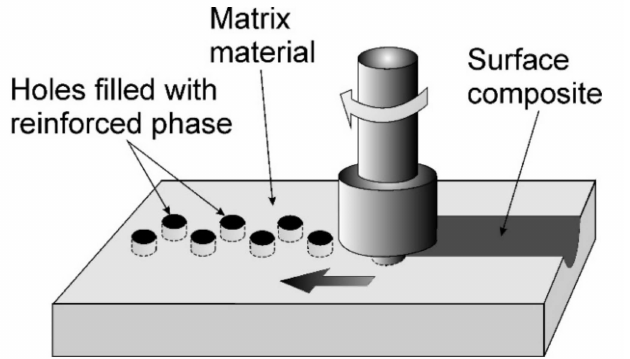
Figure 5. Diagram of zigzag hole method (authors’ own